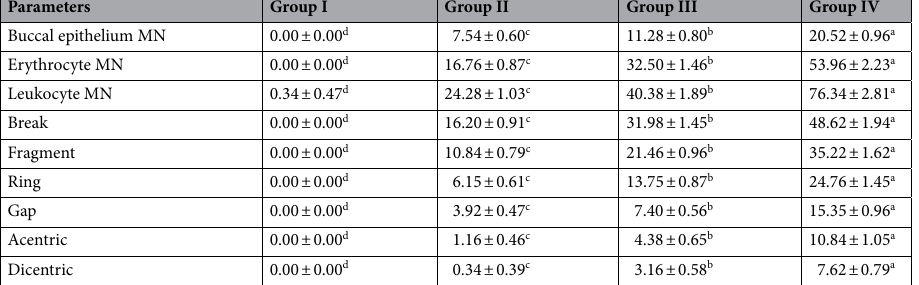
Table 4. Genotoxic effects of cypermethrin. *Group I: control, Group II: 62.5 mg/kg b.w cypermethrin, Group III: 125 mg/kg b.w cypermethrin, Group IV: 250 mg/kg b.w cypermethrin. MN: Micronucleus. 1000 cells were analyzed for MN frequency and 600 cells were analyzed for CAs in each group. Values are shown as mean ± SEM (n = 6). Data were analyzed with SPSS computer program using Duncan test and ANOVA variance analysis. The averages shown with different letters (a–d) on the same line are statistically significant ( p <